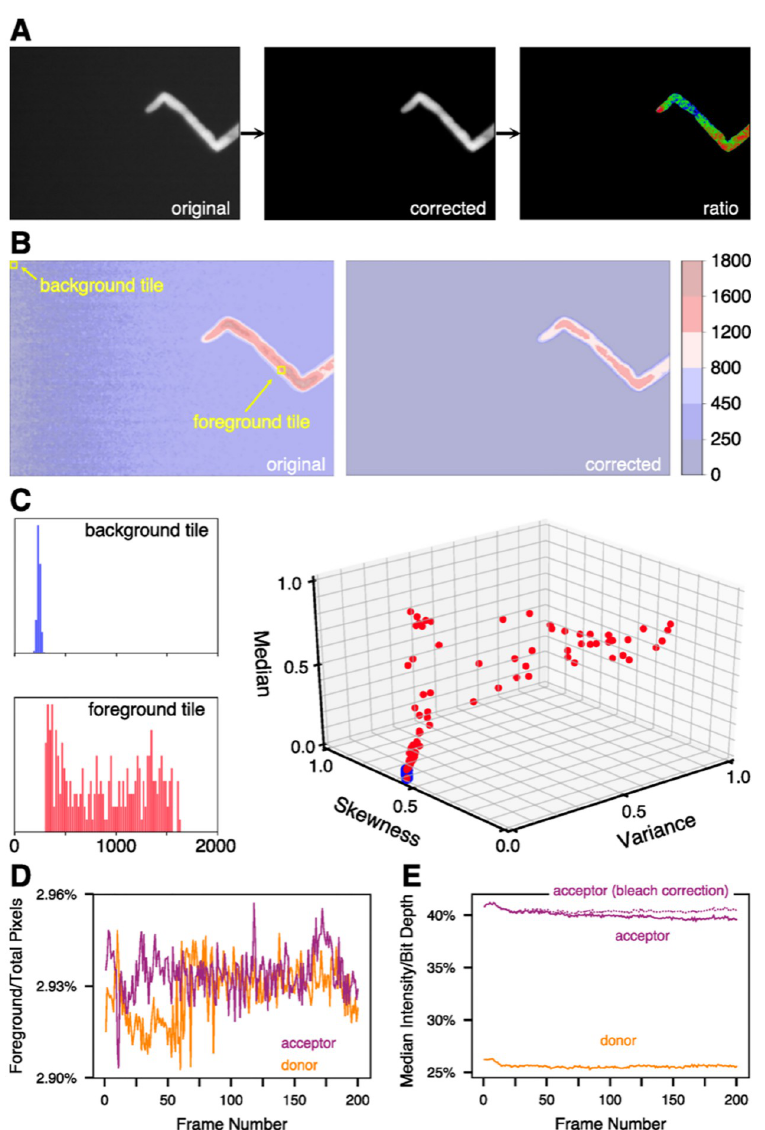
Fig 1. FRET-IBRA workflow. A) Image evolution from the original image to the background-corrected image and the final ratiometric image. B) A contour map of the pixel intensities of the original and corrected images. C) Pixel intensity distributions of example background and foreground tiles shown in B), along with the reduced feature space showing median, skewness, and variance, with each point representing a tile. The blue cluster indicates the background tiles, while the red cluster indicates foreground tiles. D) The percentage of foreground pixels can be used to control the quality of the background subtraction for each channel. E) The median signal intensity of donor and acceptor channel allows for analysis and correction of bleaching effects, and serves as a an additional quality indicator for background subtraction.